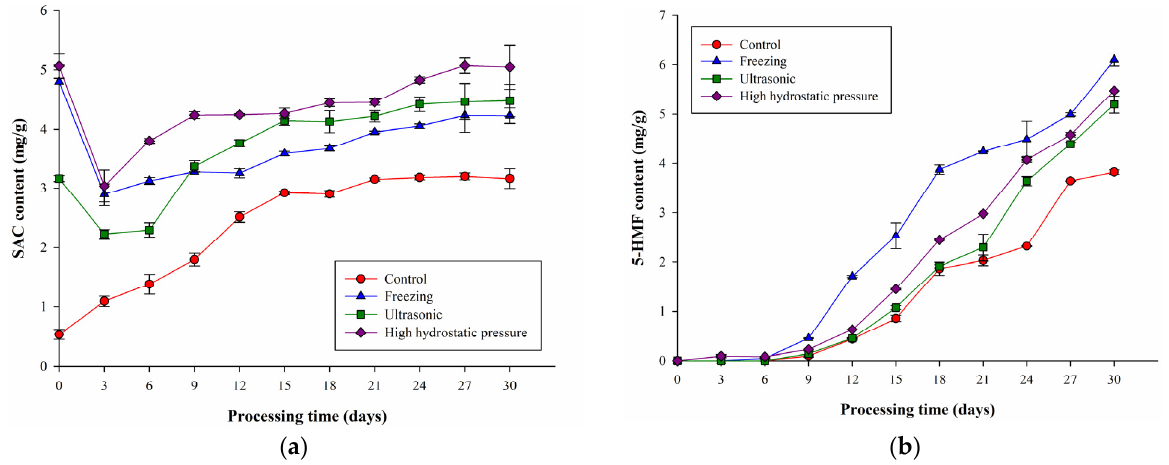
Figure 2. ( a ) SAC content (mg/g dry weight) and ( b ) 5-HMF content (mg/g) in garlic subjected to different pretreatment methods during thermal processing (70 °C, 80% RH for 30 days). All values are means ± standard deviations ( n = 3). Control: only heat treatment at 40 °C, 80% RH for 6 days. Freezing: frozen at − 20 °C for 30 h and then heat-treated at 40 °C with 80% RH for 6 d. Ultrasonic: 28 kHz for 2 h and then heat-treated at 40 °C with 80% RH for 6 d. High hydrostatic pressure: 300 MPa for 15 min and then heat-treated at 40 °C with 80% RH for 9 d.